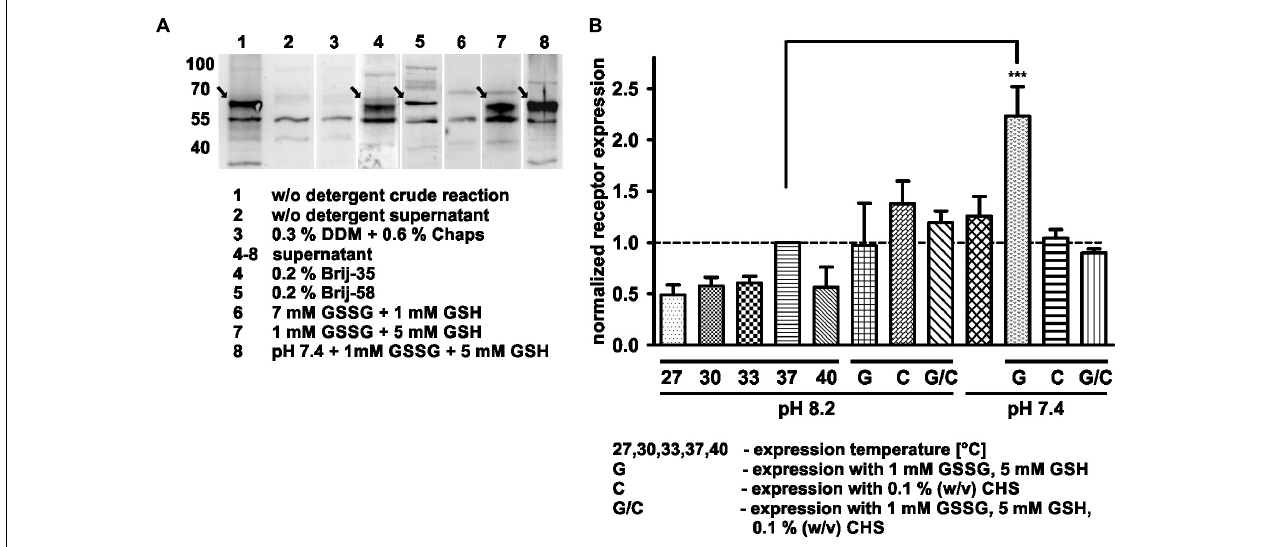
FIGURE 1 | Optimization of cell-free Y 2 R_eGFP expression. (A) Western Blot of cell-free expressed hY 2 R_eGFP at different conditions (selected shown, spliced from different Western Blots). To monitor soluble receptor expression the crude reaction (1, 3) was centrifuged for 2 min at 13,000 rpm and the supernatant (2, 4–8) used for analysis. Without detergents (2), the receptor remains insoluble, while addition of DDM and Chaps (3) completely inhibits receptor expression. The addition of Brij-35 (4) or Brij-58 (5) led to high amounts of solubly expressed receptor. To promote disulfide bridge formation oxidized (GSSG) and reduced (GSH) glutathione were used. While a higher amount of GSSG inhibits soluble receptor expression (6), an increased amount of GSH promotes it (7). The effect was further increased by lowering the pH of expression buffer toward pH 7.4 (8). (B) Analysis of receptor expression based on fluorescence measurements and Western Blot analysis. All samples were normalized to receptor expression at 37 ◦ C, without additives, with expression buffer at pH 8.2. The receptor expression was tested at different temperatures (27, 30, 33, 37, and 40 ◦ C) without additives and at 37 ◦ C with 1 mM GSSG/5 mM GSH (G), 0.1% cholesteryl hemisuccinate (CHS, C) or with 1 mM GSSG, 5 mM GSH and 0.1% cholesteryl hemisuccinate (G/C) by using an expression buffer at pH 8.2 or 7.4. The expression in the presence of 1 mM GSSG and 5 mM GSH at pH 7.4 leads to a significantly increased receptor expression. Arrows indicate synthesized receptors. DDM, n -dodecyl β - D -maltoside;